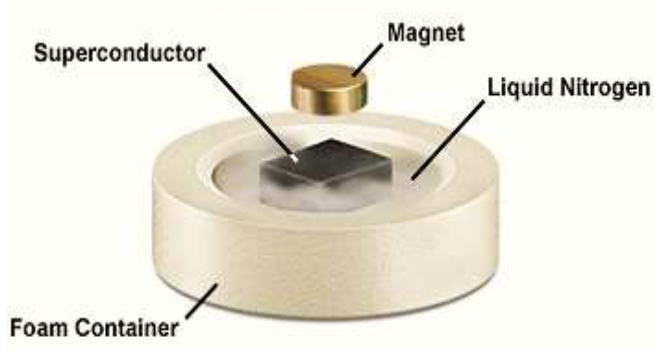
Figure 2: Meissner Effect in Superconducting state.